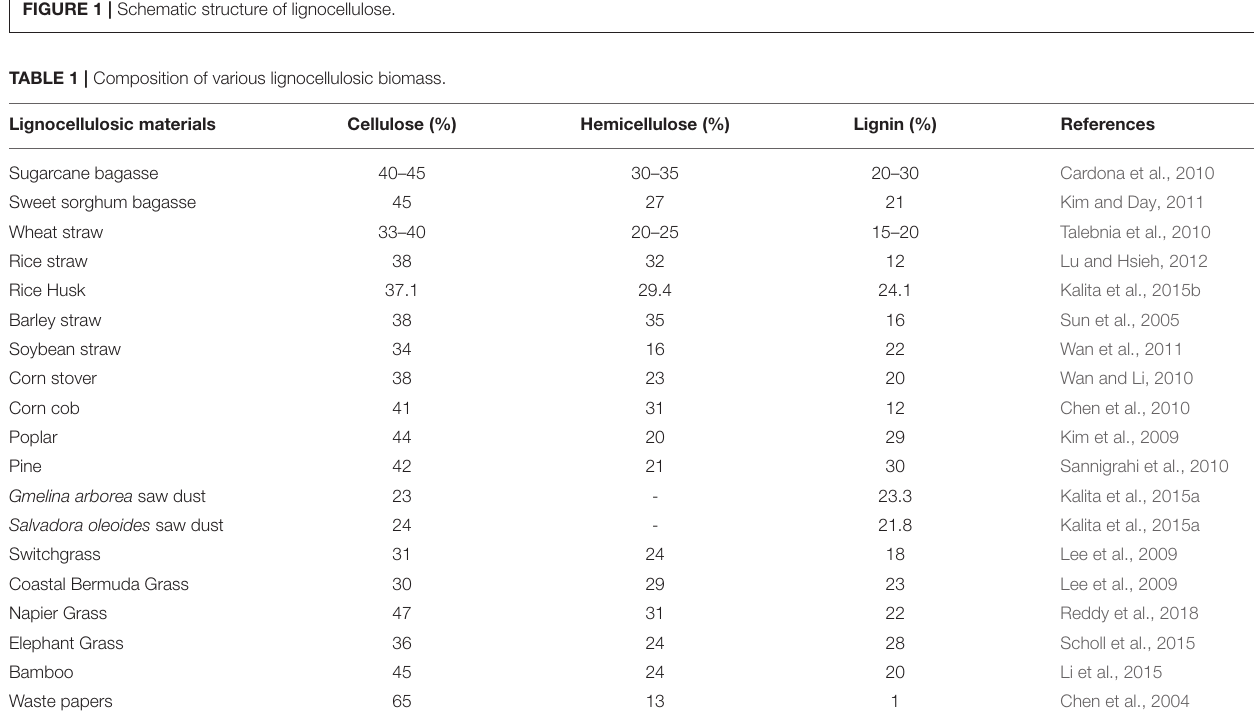
FIGURE 1 | Schematic structure of lignocellulose.